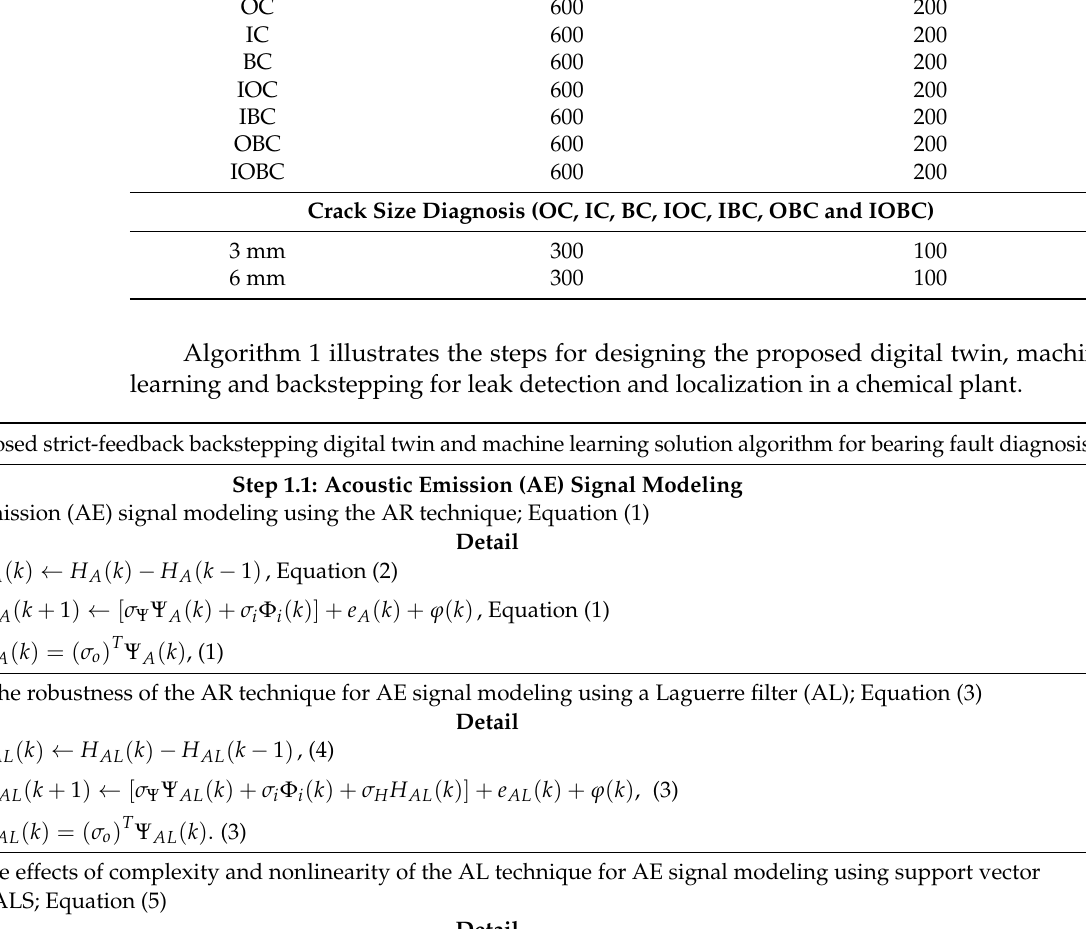
Table 3. Training and testing samples for RMS residual signals for signal classification using the SVM. States Training Samples (Numbers) Testing Samples (Numbers) Crack Type Diagnosis